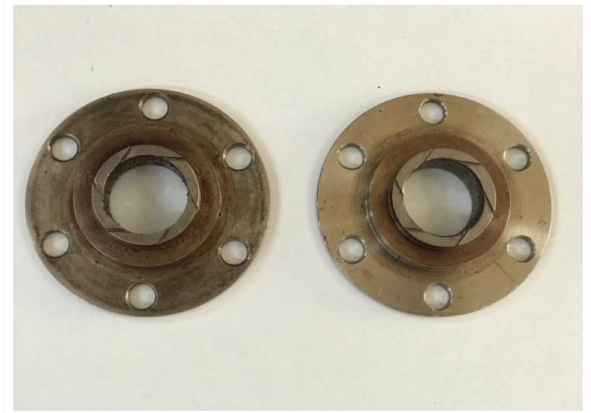
Figure 4. The swirling rings of the discharge chamber.